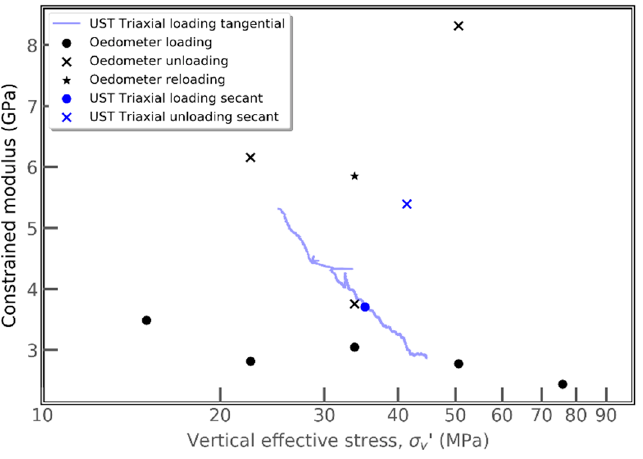
Figure 12. A comparison between secant constrained modulus from incremental loading in the oedometer (black) and secant (blue markers) and tangential (blue line) constrained modulus in the uniaxial strain triaxial test.